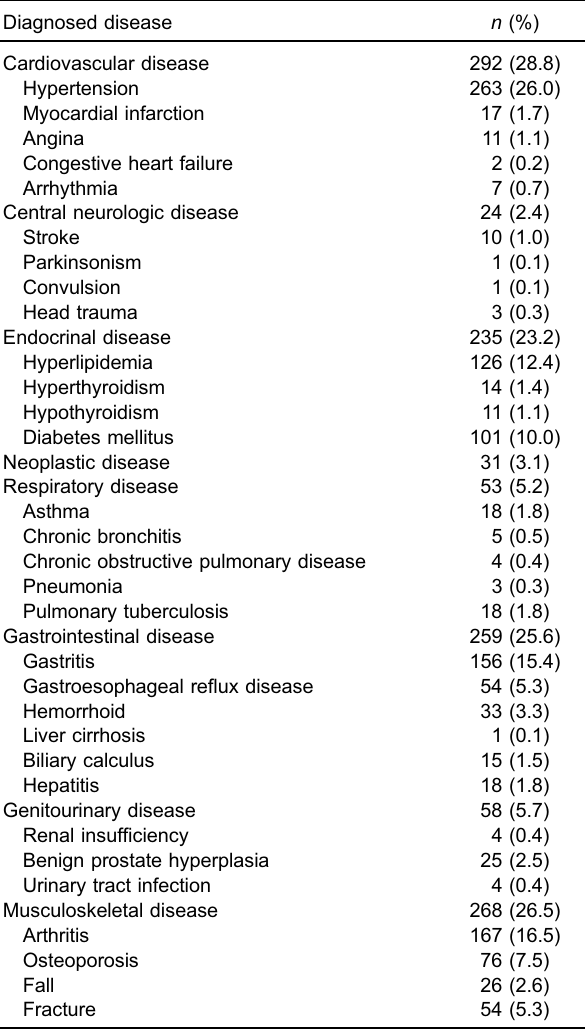
Table 5. Medical history of diagnosed diseases ( n = 1013 a ) Diagnosed disease n (%) Cardiovascular